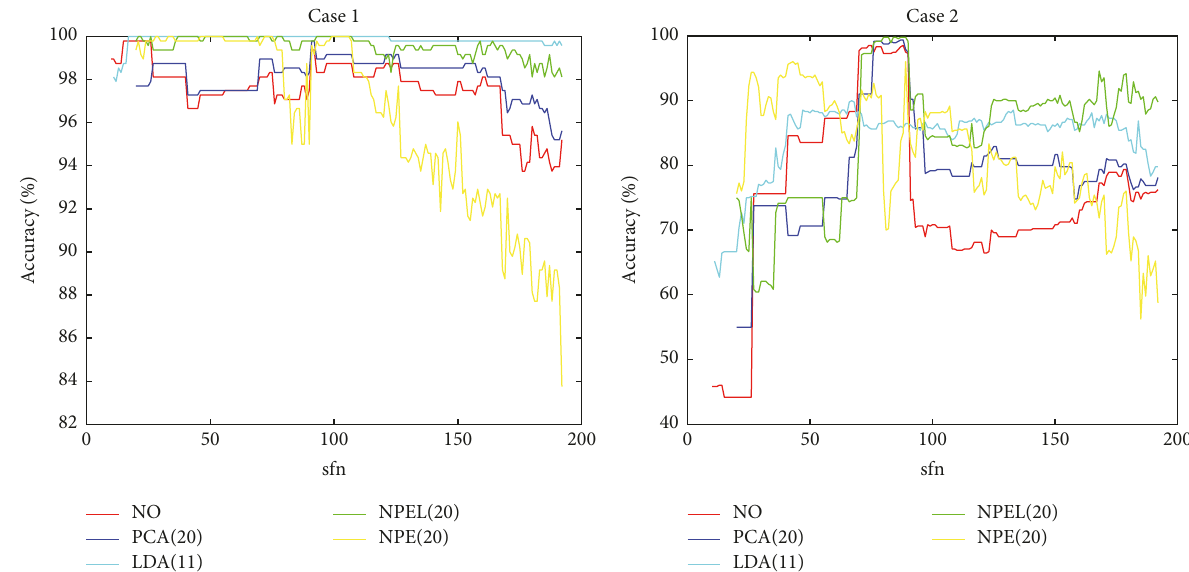
Figure 21: The diagnosis results of models using WPT for the testing sets of two cases with the use of FSASD and different dimensionality reduction methods. The output dimension sizes of PCA, LDA, and SNPEL are 20, 11, and 20, respectively. The “NO” represents the model without using dimensionality reduction method.